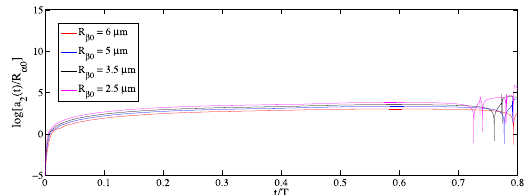
Figure 5. Temporal evolution of a 2 ( t ) for different initial radii of bubble b ( T = 50 l s, R a 0 = 4.5 l